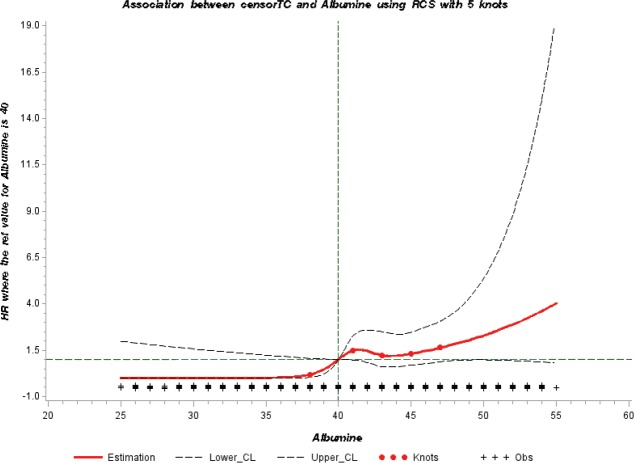
Dose response relationship between serum albumin levels and HR of testicular cancer by RCS curve with 5 knots of albumin values at 5th, 25th, 50th, 75th, 95th percentiles [Reference value of albumin = 40 g/L]